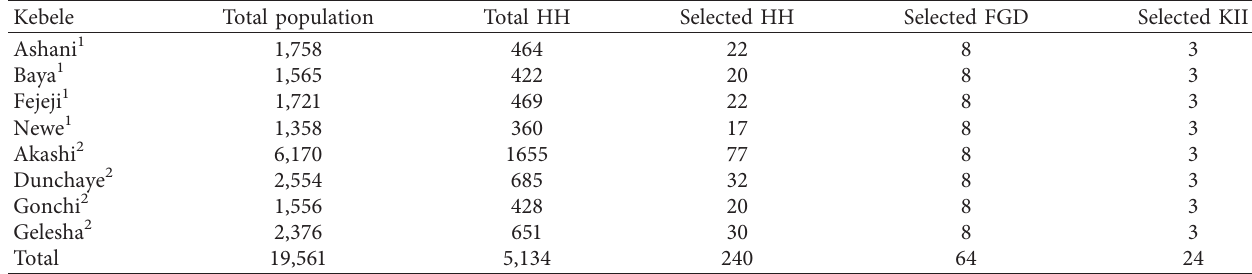
Table 4: The number of participants in the HH, FGD, and KII in all kebeles.